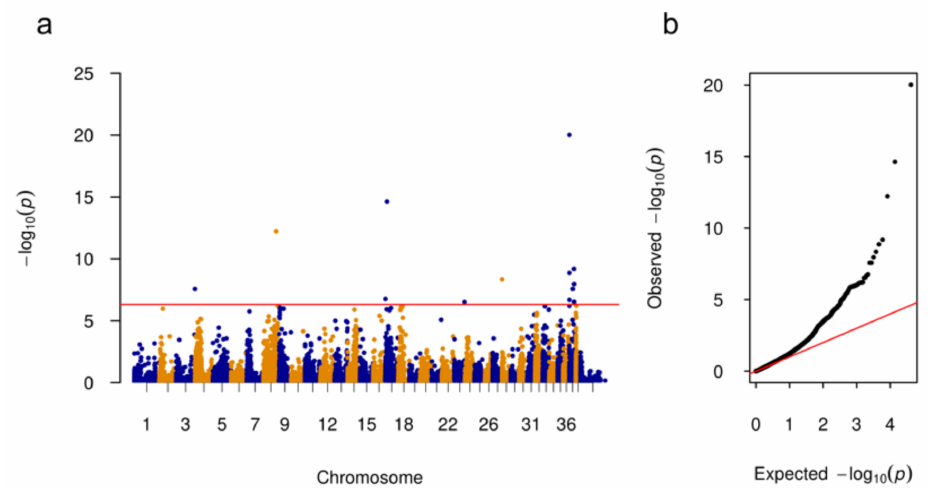
Figure 1. Manhattan and quantile–quantile (QQ) plots illustrating deafness associated chromosomal regions. ( a ) The Manhattan plot shows on the y -axis the negative log-base-10 of the p value for each of the polymorphisms in the genome (along the x -axis), when tested for differences in frequency between 3 bilateral deaf dogs (cases) and 44 controls (1 × ASCD, 43 herding dogs of 15 dog breeds). The red line indicates the Bonferroni significance threshold ( − log 10 (0.01/20,656) = 6.32). ( b ) The QQ plot depicts the distribution of p -values of the genome-wide association study (GWAS) analysis and genomic inflation factor lambda is